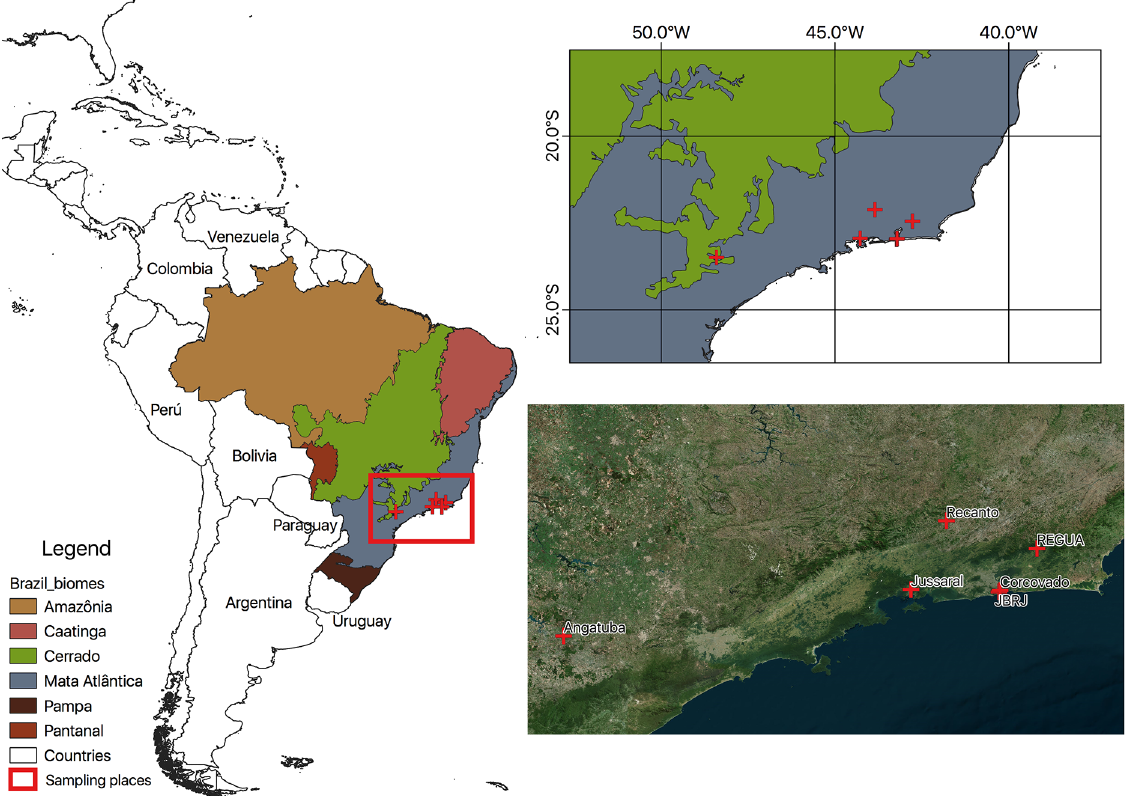
Fig. 9. Map of South America highlighting Brazilian biomes and the known distribution of Vates phoenix sp. nov. in the Atlantic Rainforest. The highly disrupted state of this biome can be seen in the satellite image (lower right), where some of the last remains of primary forest can be appreciated along the coast. See Material and methods for detailed locality information. Maps not to